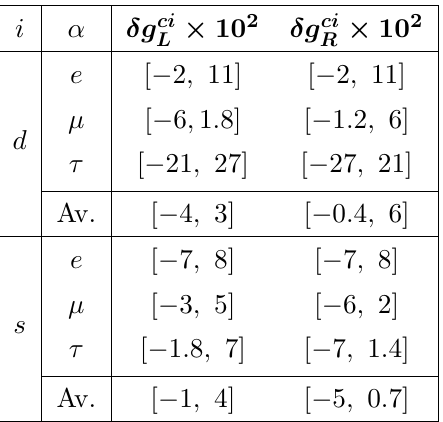
Table 5 . 95% CL limits on Wcd i vertex corrections assuming only one coupling active at a time. See section 5.2 for